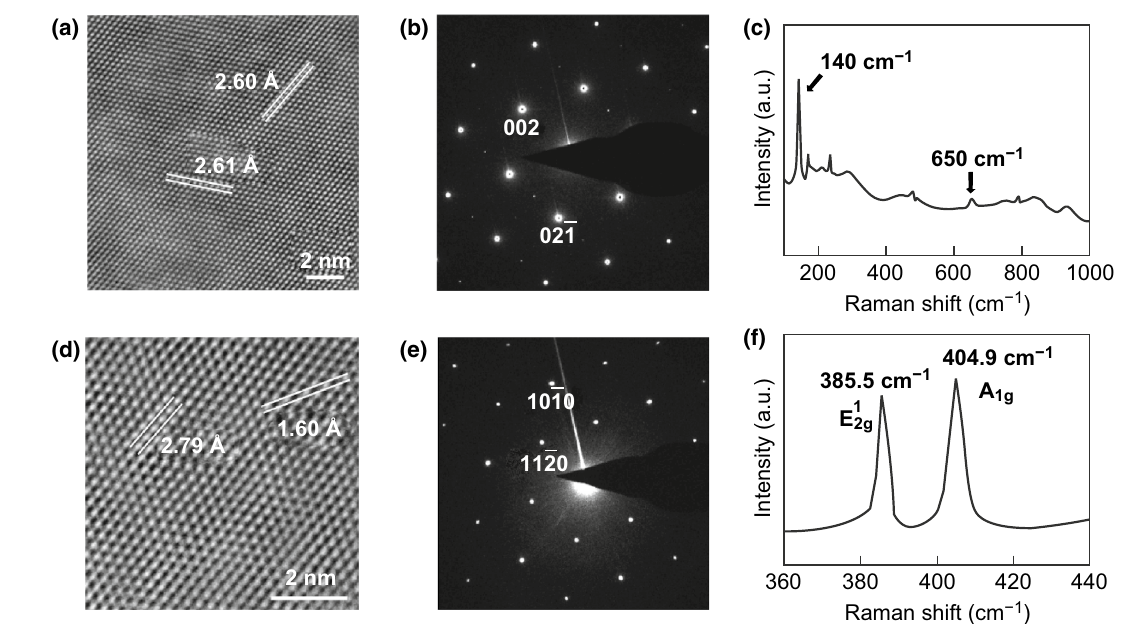
̄ 100 ] zone axis. c Raman spectrum of MoS 2 .